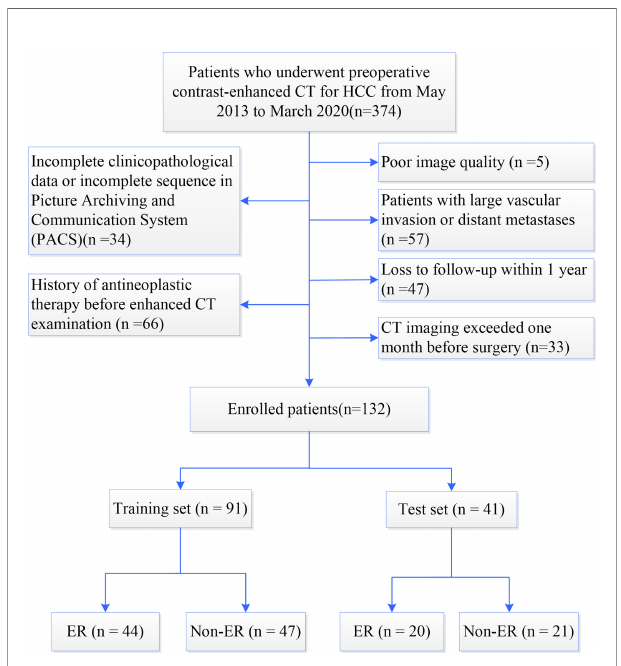
FIGURE 1 | Flowchart of patient enrollment. HCC, hepatocellular carcinoma; CT, computed tomography; ER, early recurrence; Non-ER, non-early